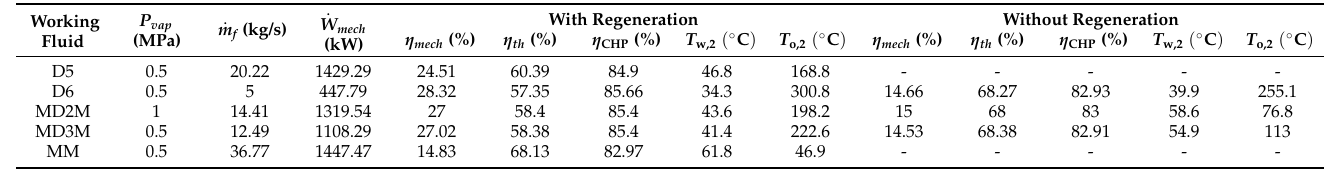
Table 6. Comparative presentation of the results for the siloxanes assumed in the present